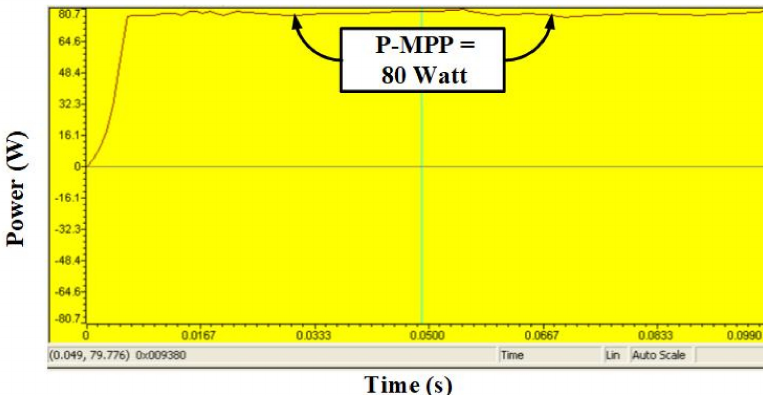
Figure 20. PV power for DSM based FLC at partial shading condition.